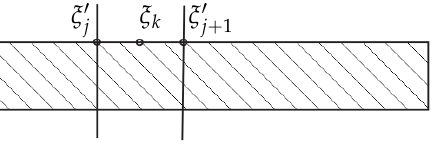
Figure 2. Cross-section showing a segment with nodes ξ (cid:48) and ξ (cid:48) and the midpoint ξ k . j j + 1 Each diagonal entry in the coupling matrix ˆ G represents the hydrodynamic influence coefficients of segments of the same beam with itself, whereas each off-diagonal entry comprises elements representing the hydrodynamic coupling generated by the neighbour- ing (( m + 1 ) th and ( m − 1 ) th) and non-neighbouring (( m + i ) th and ( m − i ) th) (where i is not equal to 1) members on the m th beam. For example, G 11 contains hydrodynamic influence coefficients on the first beam from segments of the same beam, whereas G 12 contains hydrodynamic influence coefficient of the first beam subject to the influence of the segments of the second beam, and so on. In order to compute the elements of sub-matrix G 11 a loop is run over the number of nodes j ( 0, ..., N ) for each midpoint k ( 0, ..., N − 1 )